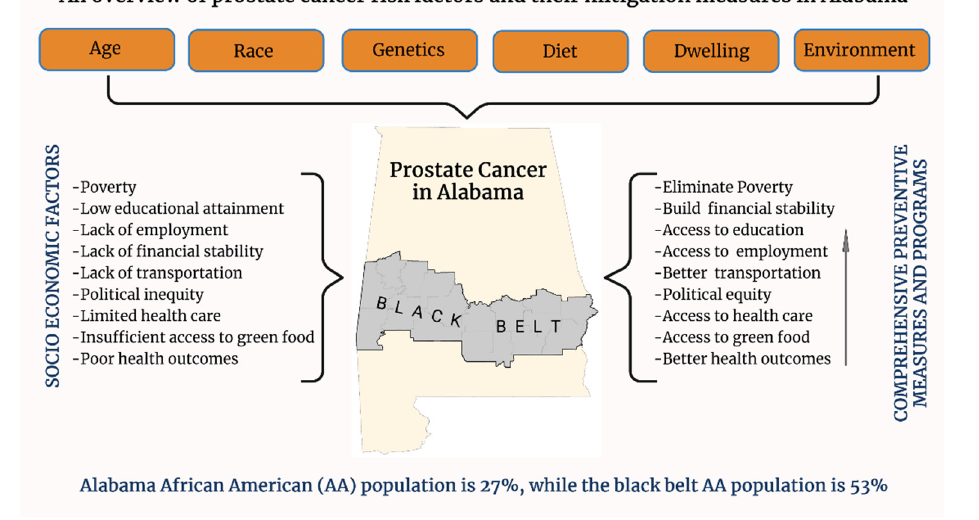
Figure 6. An overview of prostate cancer risk factors in Alabama. This figure summarizes the risk factors and preventive measures that need to be considered to reduce prostate cancer health disparity and bring equity among races.